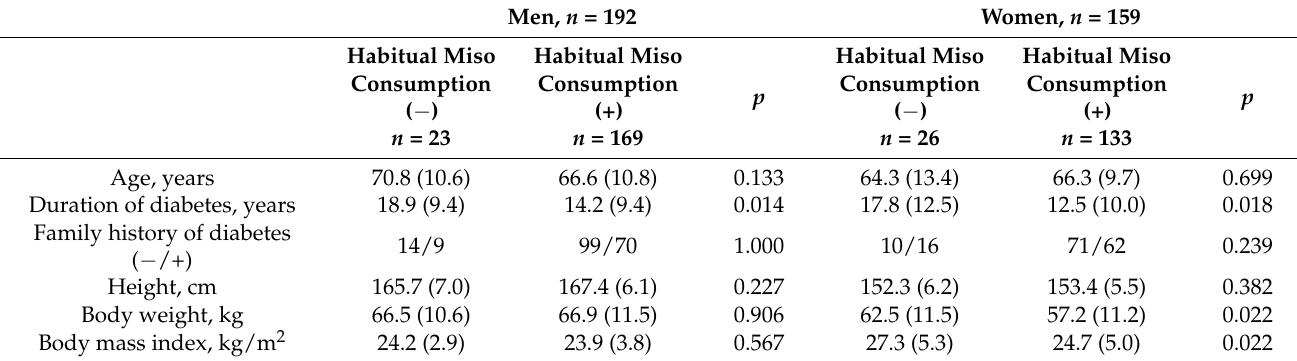
Table 3. Clinical characteristics according to habitual miso